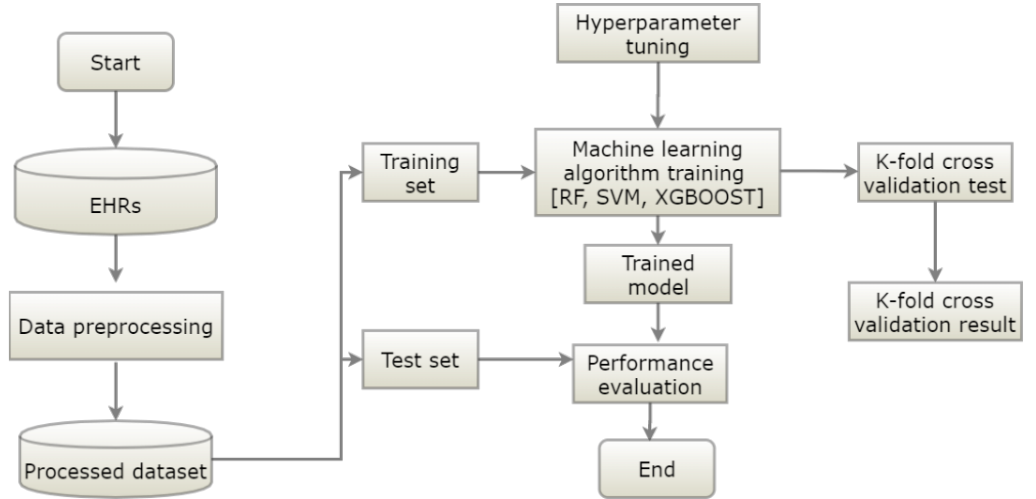
Figure 3. The architecture of the prediction model (RF = random forest, XGB = XGBoost, SVM = support vector machine).